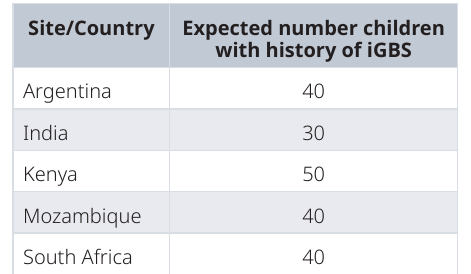
Table 3. Expected number of children with history of iGBS, by site, for the long-term outcomes study.